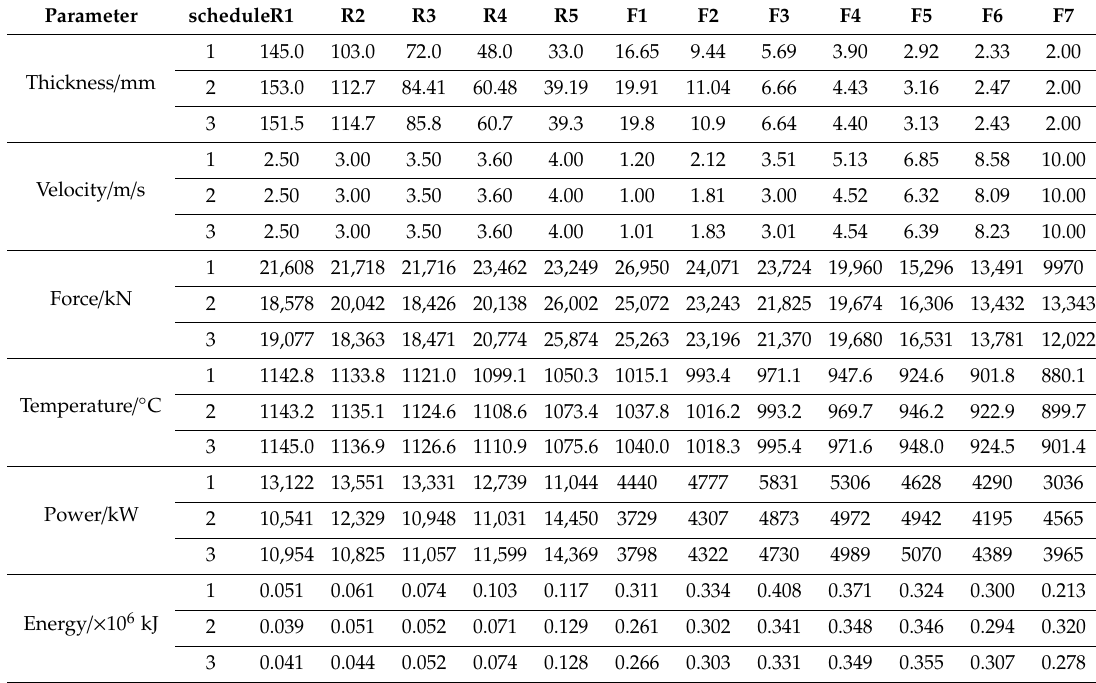
Table 5. Details of three schedules.